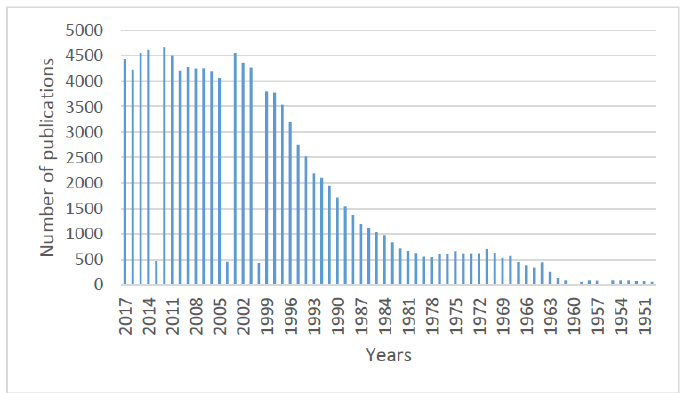
Figure 3. Number of publications per year (January 1950–December 2017). Database: